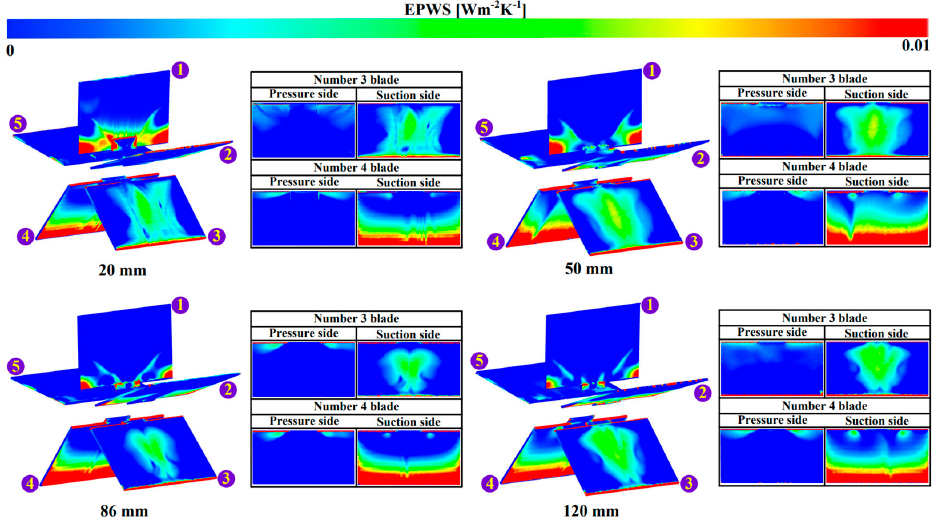
Figure 16. Distribution of EPWS in the blades of water wheels under different clearance configurations.